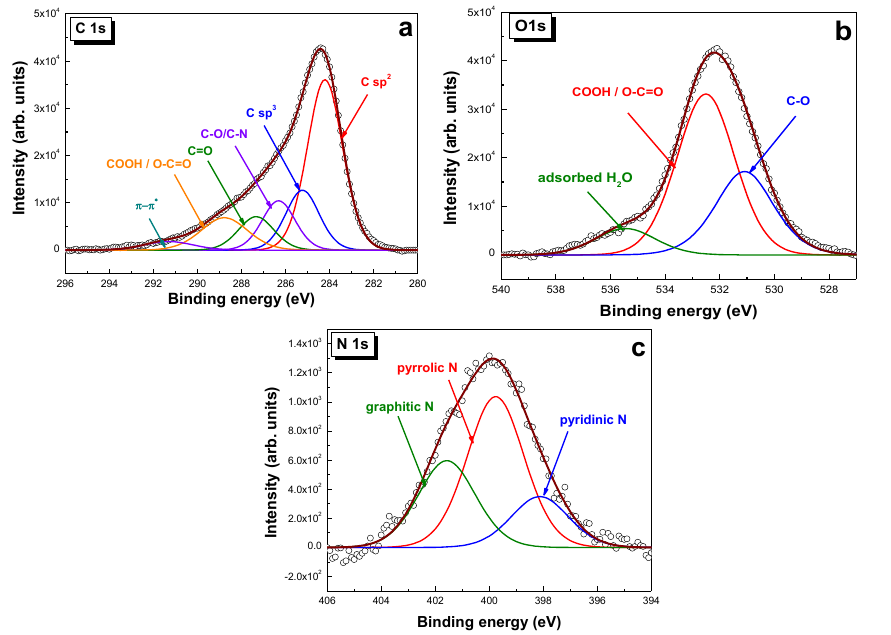
Figure 3. Deconvoluted high–resolution XPS spectra of C1s ( a ), O 1s ( b ), and N 1s ( c ) states corre- sponding to exf-NGr.